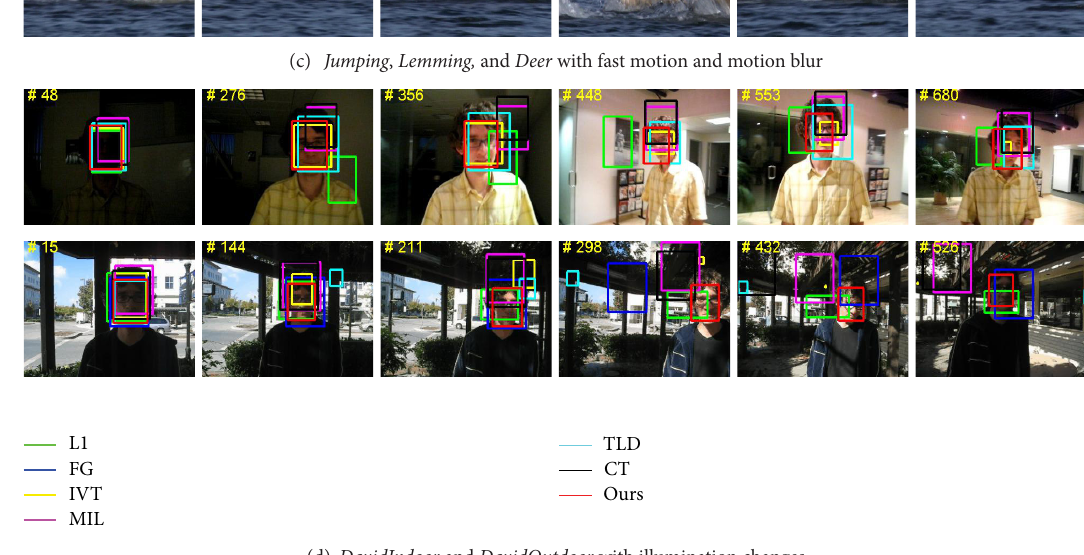
Figure 9: Tracking results on various challenging